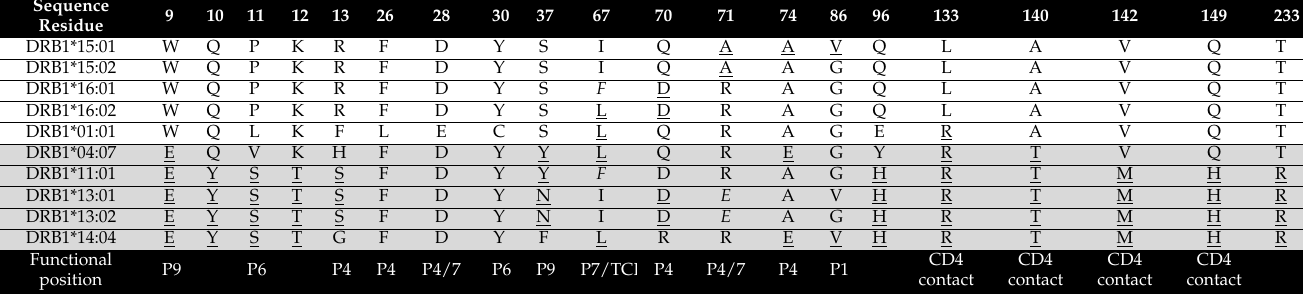
Figure 1. A multiple sequence alignment of the risk-associated HLA-DRB1 alleles (top 5) versus the protection-associated HLA-DRB1 alleles (bottom 5). Non-similar positions were colored using the physicochemical properties of the respective amino acids. Rose = hydrophobic/aliphatic; Orange = aromatic; Blue = positively charged; Red = negatively charged; Green = hydrophilic; Purple = conformationally special; Yellow = Cysteine. Table 2. Functionally important observed amino acid substitutions are shown between protection-associated (top 5, white) and risk-associated (bottom 5, greyscale) HLA alleles. Bolded residues denote amino acid variants shared across several alleles, and variants shared across remaining other alleles are underlined. The respective epitope binding pocket positions are denoted with Px. A = Alanine; C = Cysteine; D = Aspartic acid; E = Glutamic acid; F = Phenylalanine; G = Glycine; H = Histidine; I = Isoleucine; K = Lysine; L = Leucine; M = Methionine; N = Asparagine; P = Proline; Q = Glutamine; R = Arginine; S = Serine; T= Threonine; V = Valine; W = Tryptophan; Y =